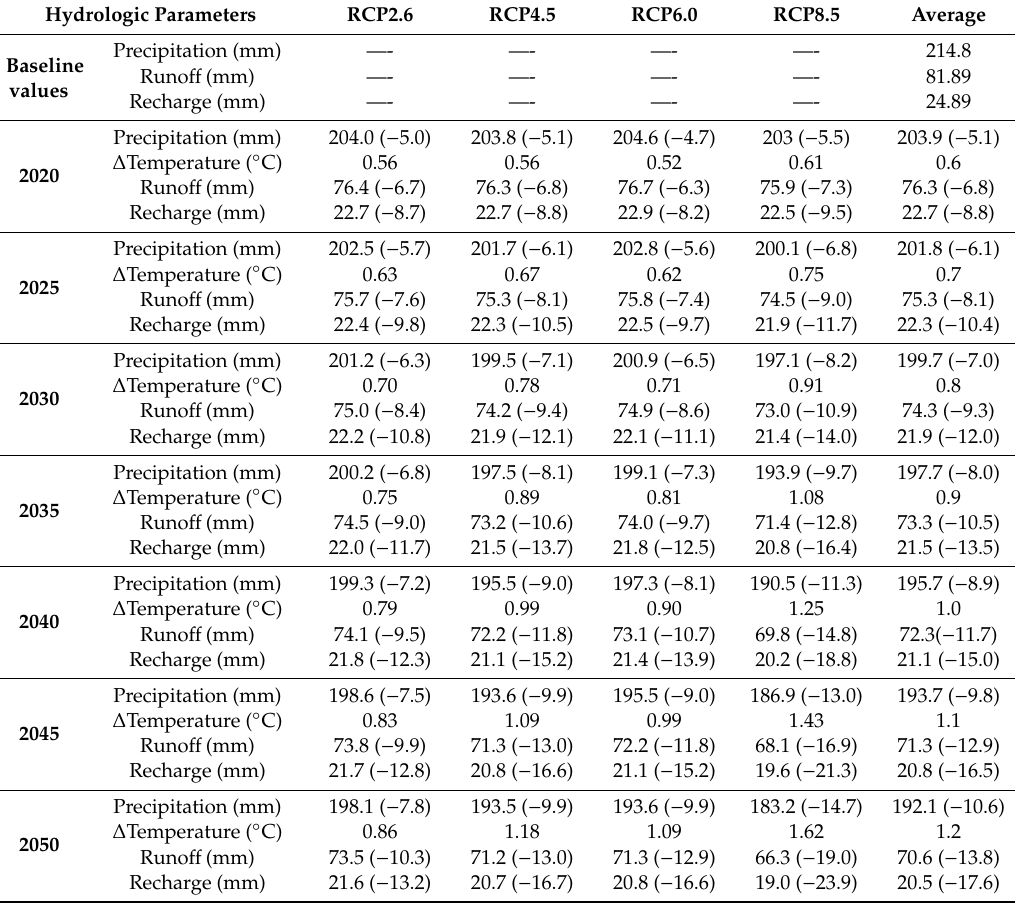
Figure 9. Monthly average (1979–2014) runoff at the outlet (solid line), potential recharge (dashed line), and precipitation (bars) in Souss Basin. Table 3. Predicted hydrologic parameters due to global climate change using data based on AR5 report of di ff erent Representative Concentration Pathways (RCPs), the values in parentheses are percentage changes from the baseline values. SWAT model